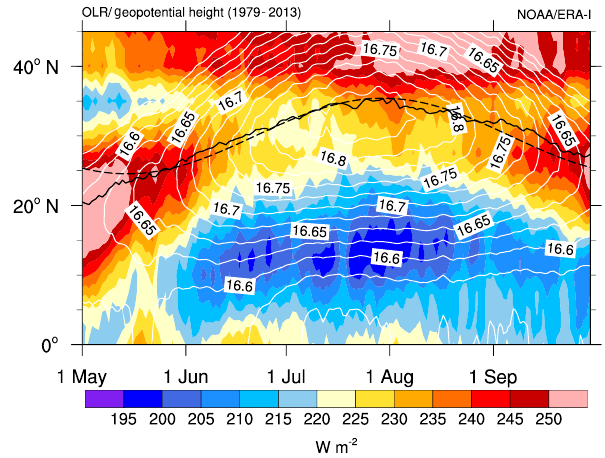
Figure 12. As Fig. 11 but for latitude vs. time. OLR and geopo- tential height (km) at 100hPa have been averaged over 70–130 and 45–100 ◦ E respectively.